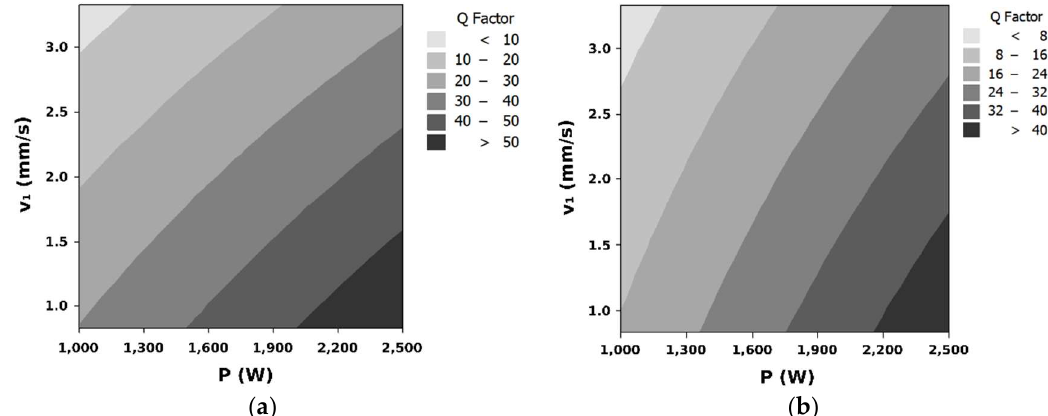
Figure 10. Quality factor evolution as a function of the laser power ( P ) and transverse speed ( v 1 ) for the processing of the ( a ) white granite and ( b ) black granite.